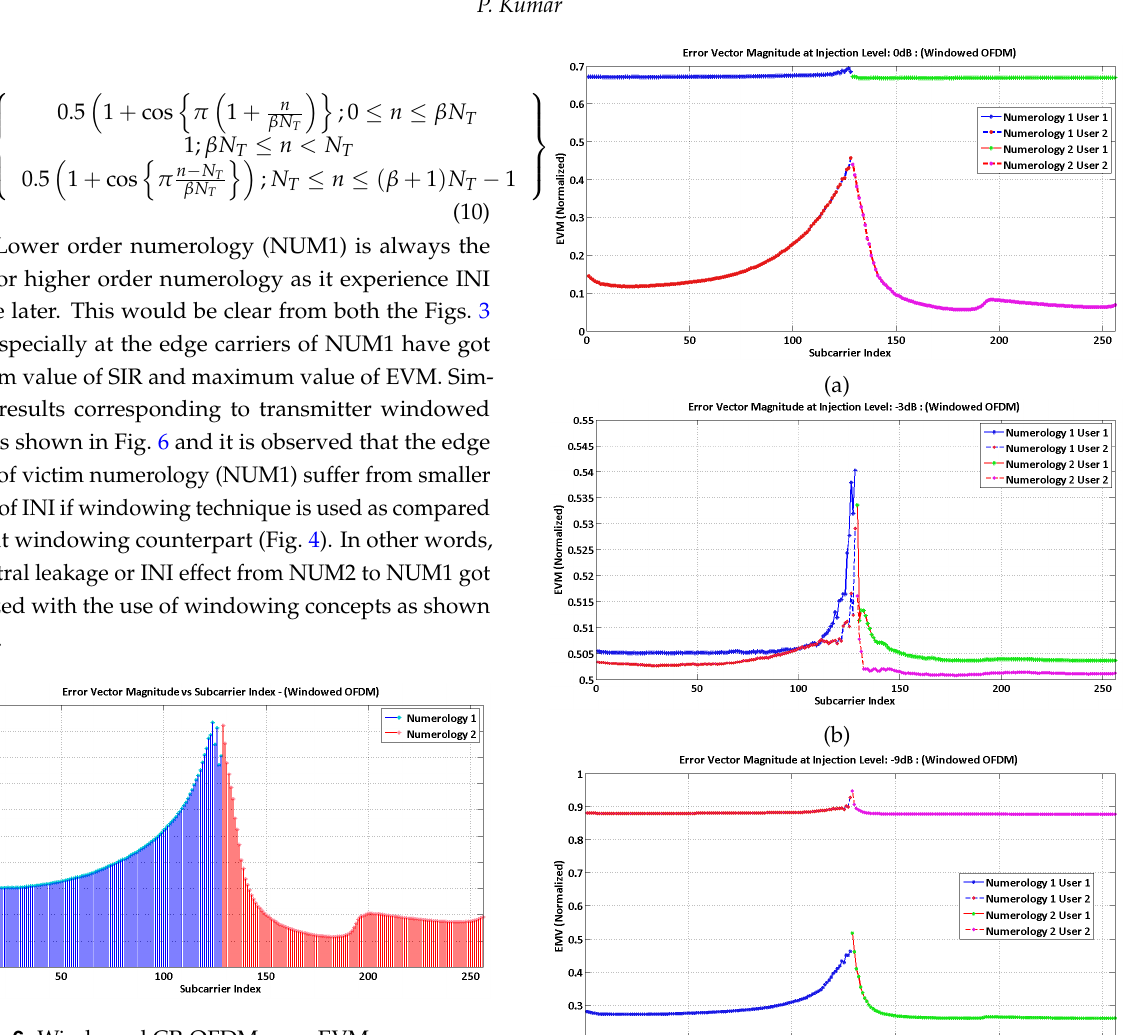
Fig. 6. Windowed CP-OFDM case: EVM versus subcarreier indices